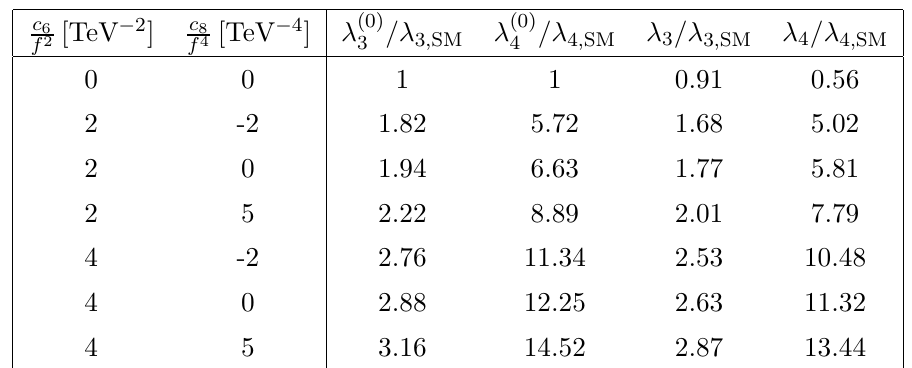
Table 1 . Comparison between tree (denoted by the superscript \ (0) ") and loop level values of (cid:21) 3 and (cid:21) 4 with respect to their SM, tree-level